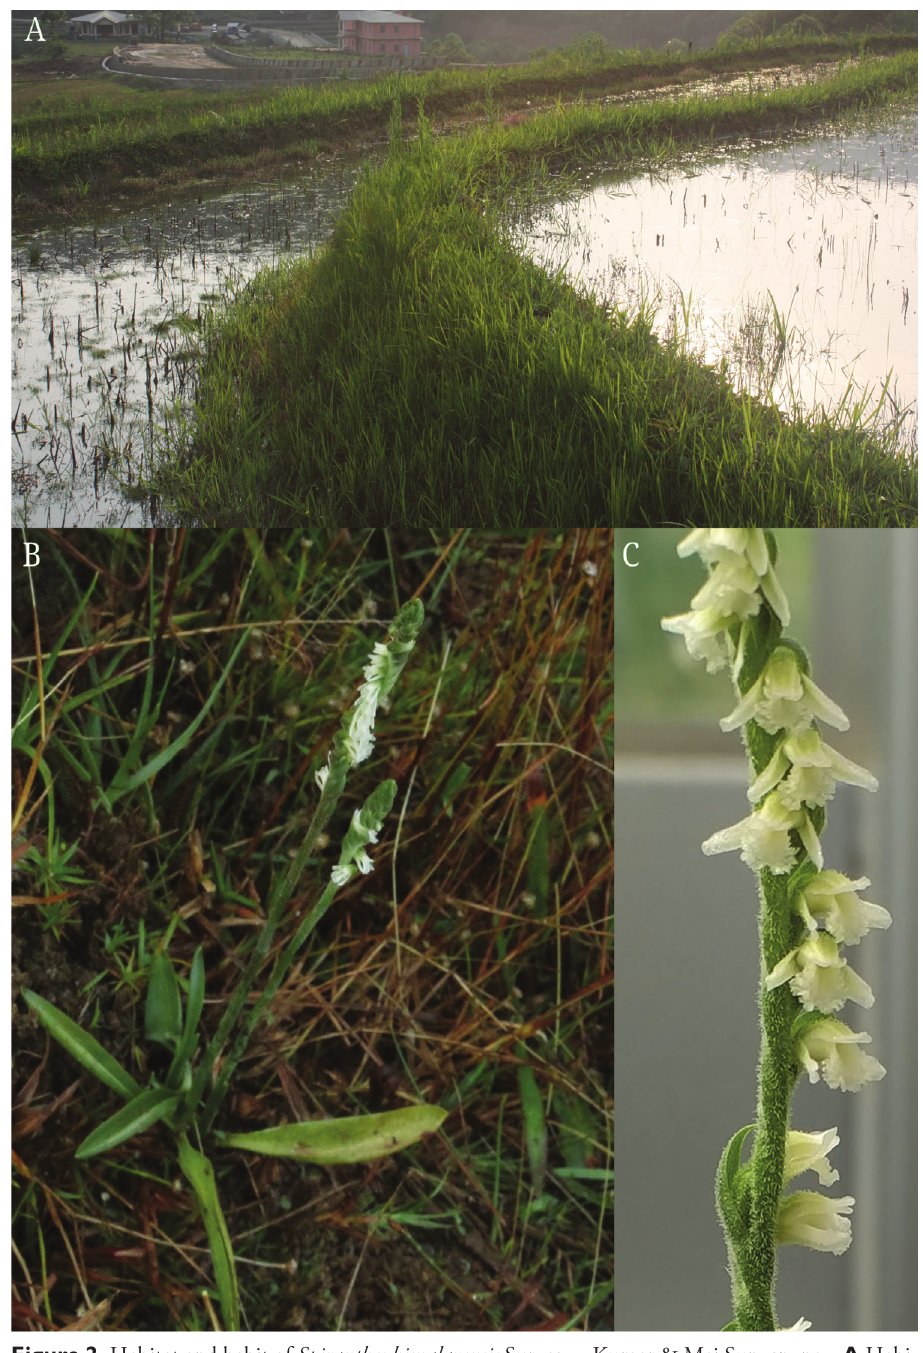
Figure 2. Habitat and habit of Spiranthes himalayensis Survesw., Kumar & Mei Sun, sp. nov. A Habi- tat (type location) - along the bunds of paddy fields B Habit of S. himalayensis C Close-up of the inflorescence showing white coloured flowers with densely covered glandular